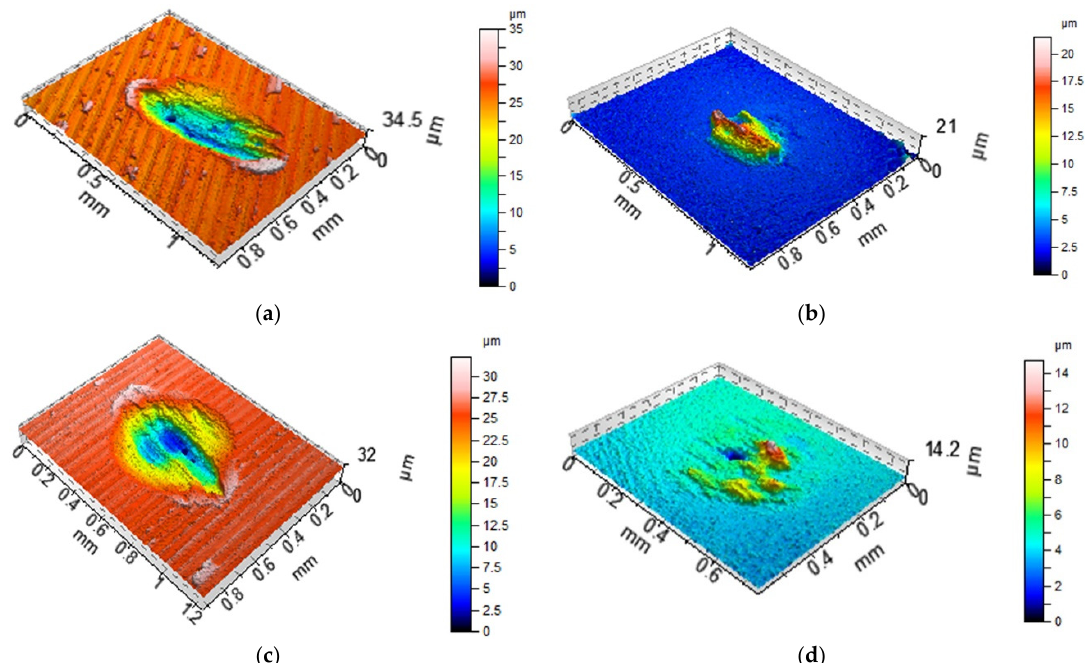
Figure 14. Isometric views of disc M3 ( a , c ) and co-acted balls ( b , d ) after tests C ( a , b ) and D ( c , d ).